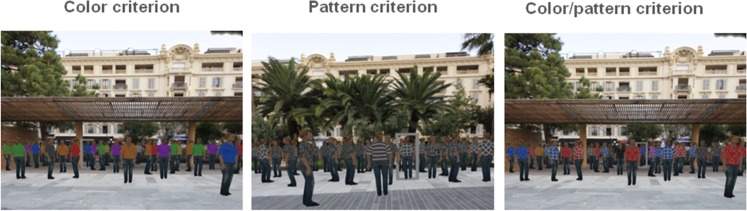
Examples of stimuli employed in the attentional task.Participants were asked to find five characters corresponding to specific criteria among a crowd of distracters.